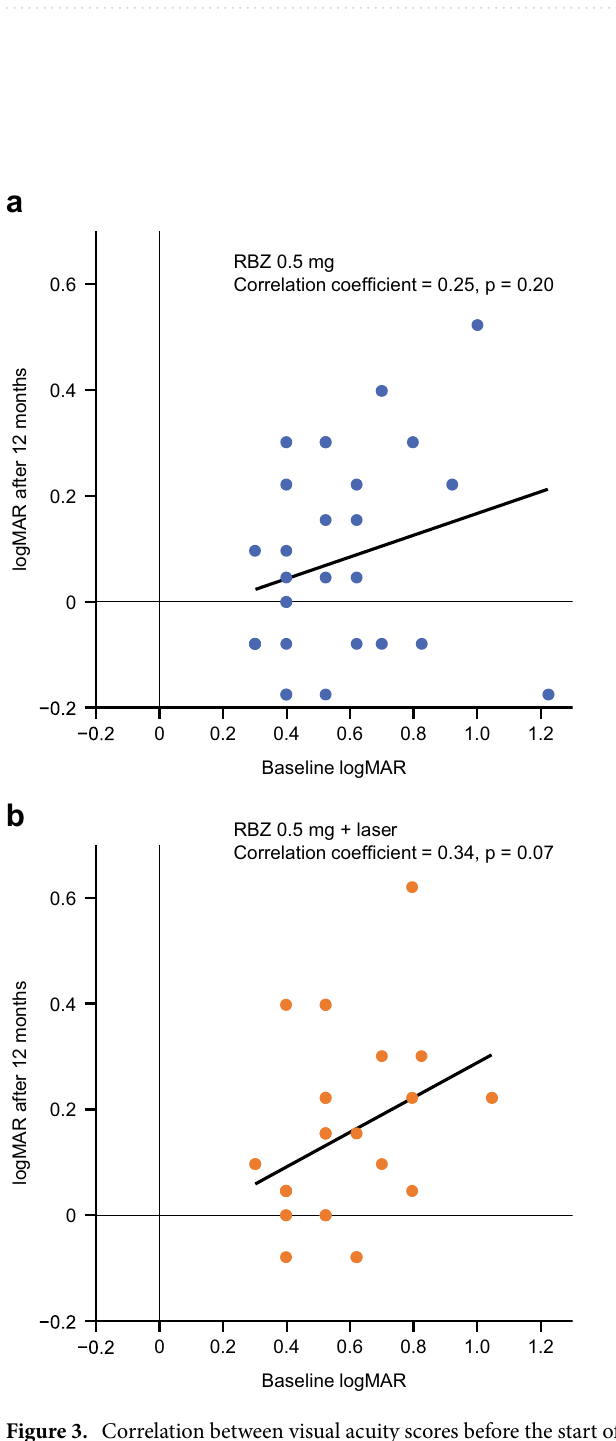
Table 1. BCVA logMAR correlations between baseline or Month 2 and Month 12. BCVA best corrected visual acuity, logMAR logarithm of the minimum angle of resolution.